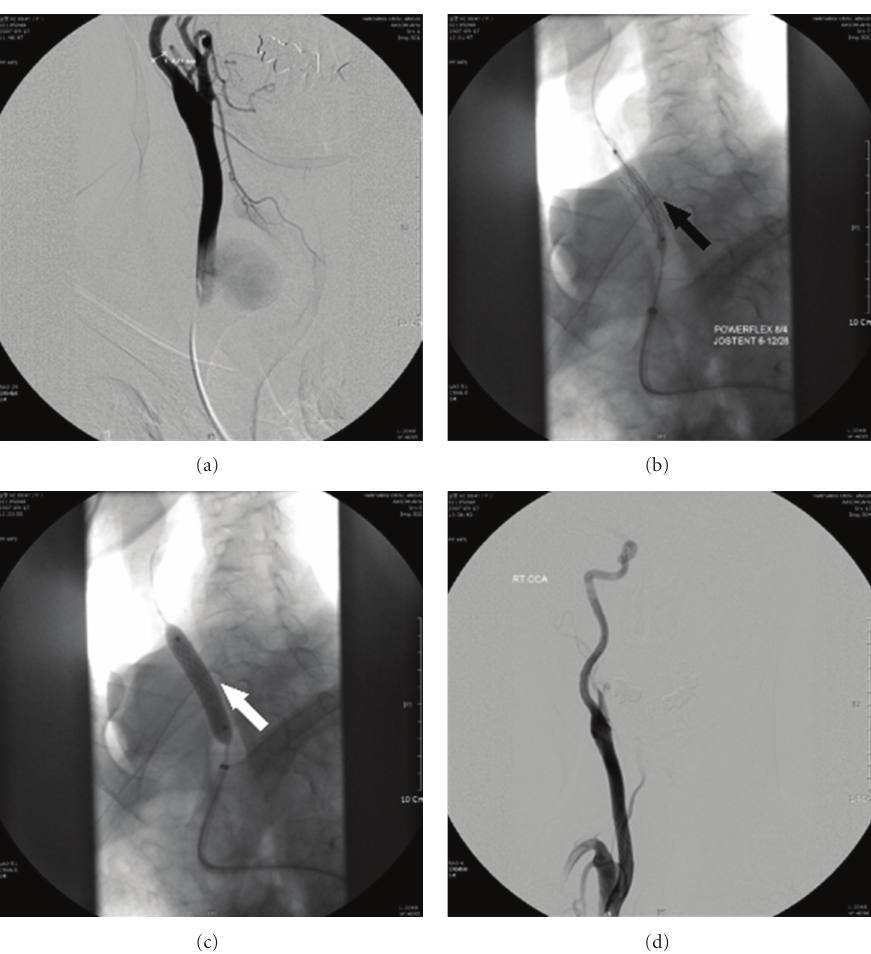
Figure 4: Intraoperative fluoroscopic image: (a) a right carotid angiogram demonstrating a pseudoaneurysm arising from the proximal common carotid artery. ((b) and (c)) The Jostent (black arrow) was deployed at the center of the fistula tract, and full dilatation was per- formed (white arrow). (d) The angiogram demonstrated a lack of contrast filling of the pseudoaneurysm after stent graft